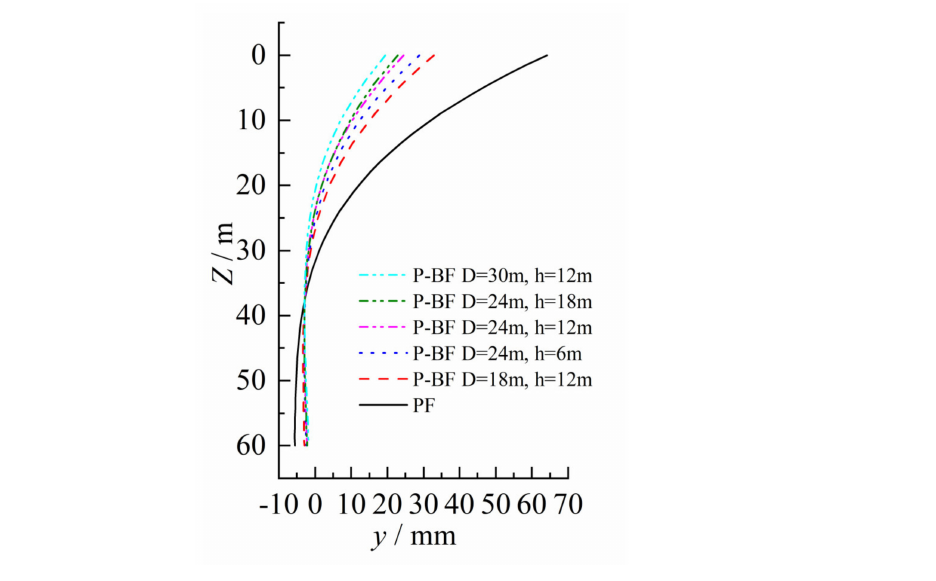
Figure 11. Lateral displacement of PF and P–BF under 5000 kN loading.